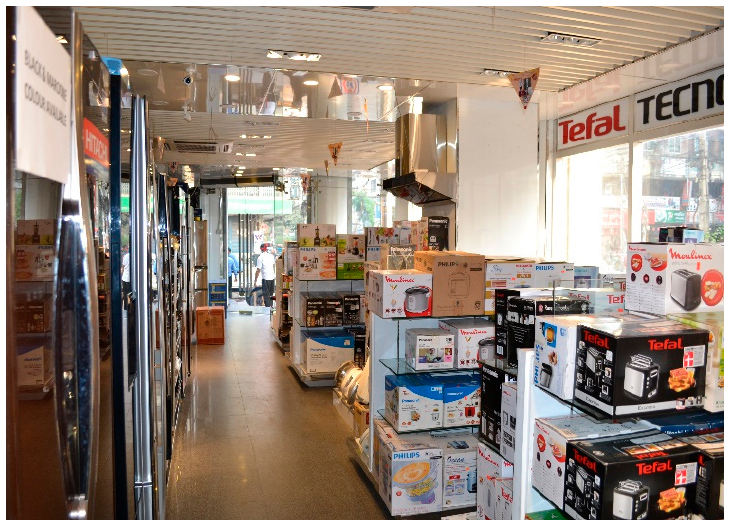
Figure 2. An electronics shop. (Source: https://lh3.ggpht.com/p/AF1QipMf1FVqbSnGOjLJswWWY_TNg_rlQlbQ4OIXt4mb=s0). (accessed on 15 July 2021).